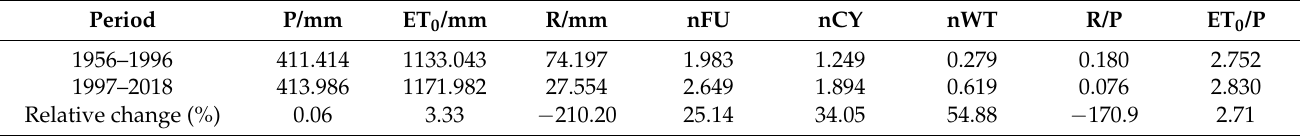
Table 2. Meteorological data and the parameters (n) of three Budyko formula for two periods.